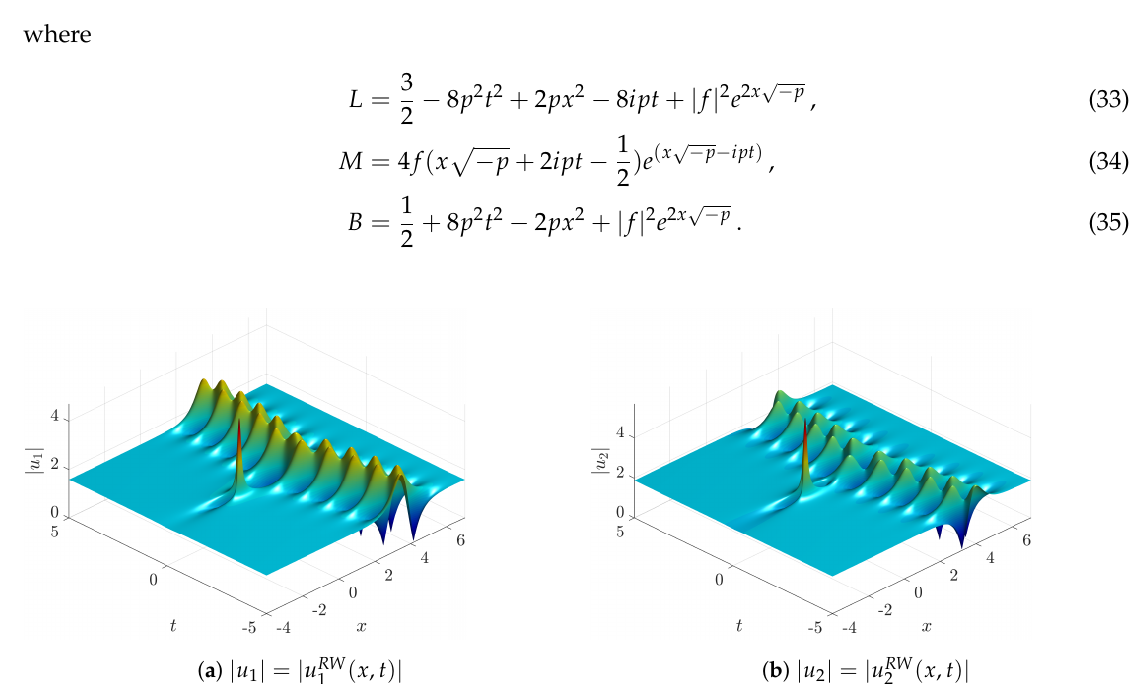
Figure 14. RWs over two co-propagating coupled background waves (e.g., the plane–wave solution of Equation (11)) with q = 0. s 1 = s 2 = − 1 (focussing), r = 1, p = − 6 ( a 1 = 1.5811, a 2 = 1.8708); λ c = 2.4495 i , f = 0.01, max | u RW